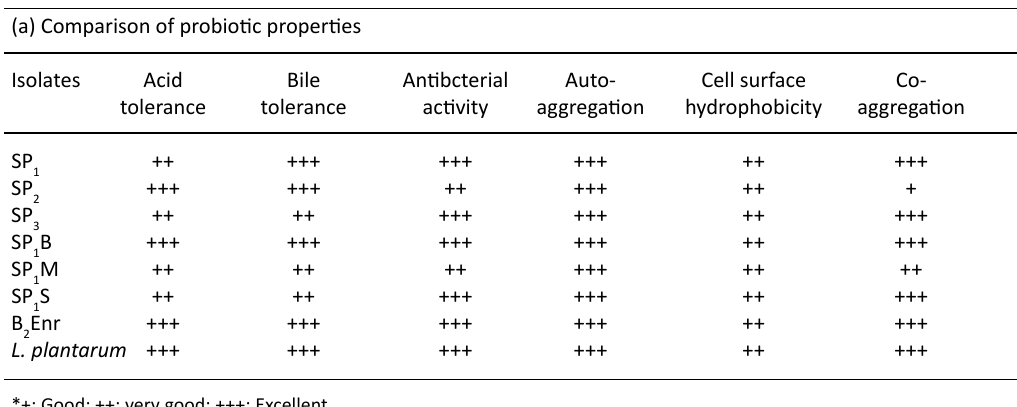
Table 5. Comparison of probiotic properties and in vitro biosafety aspects of different isolates (a) Comparison of probiotic properties Isolates